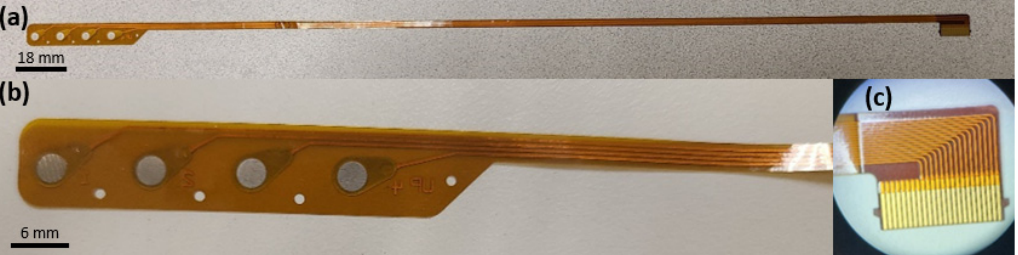
Figure 1. ( a ) Picture of a 1 × 4 strip, tail, and connector. ( b ) High magnification of the electrode contacts. ( c ) 5× magnification of the connector. contacts. ( c ) 5 × magnification of the